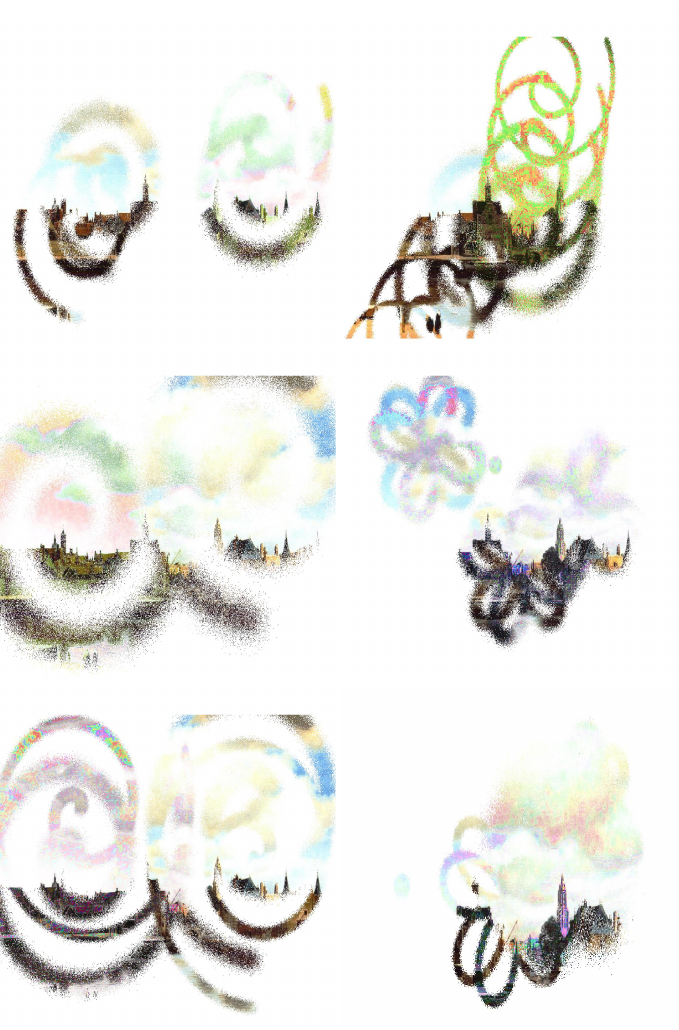
Figure 8. Color symmetric art works quoting Vermeer’s View of Delft